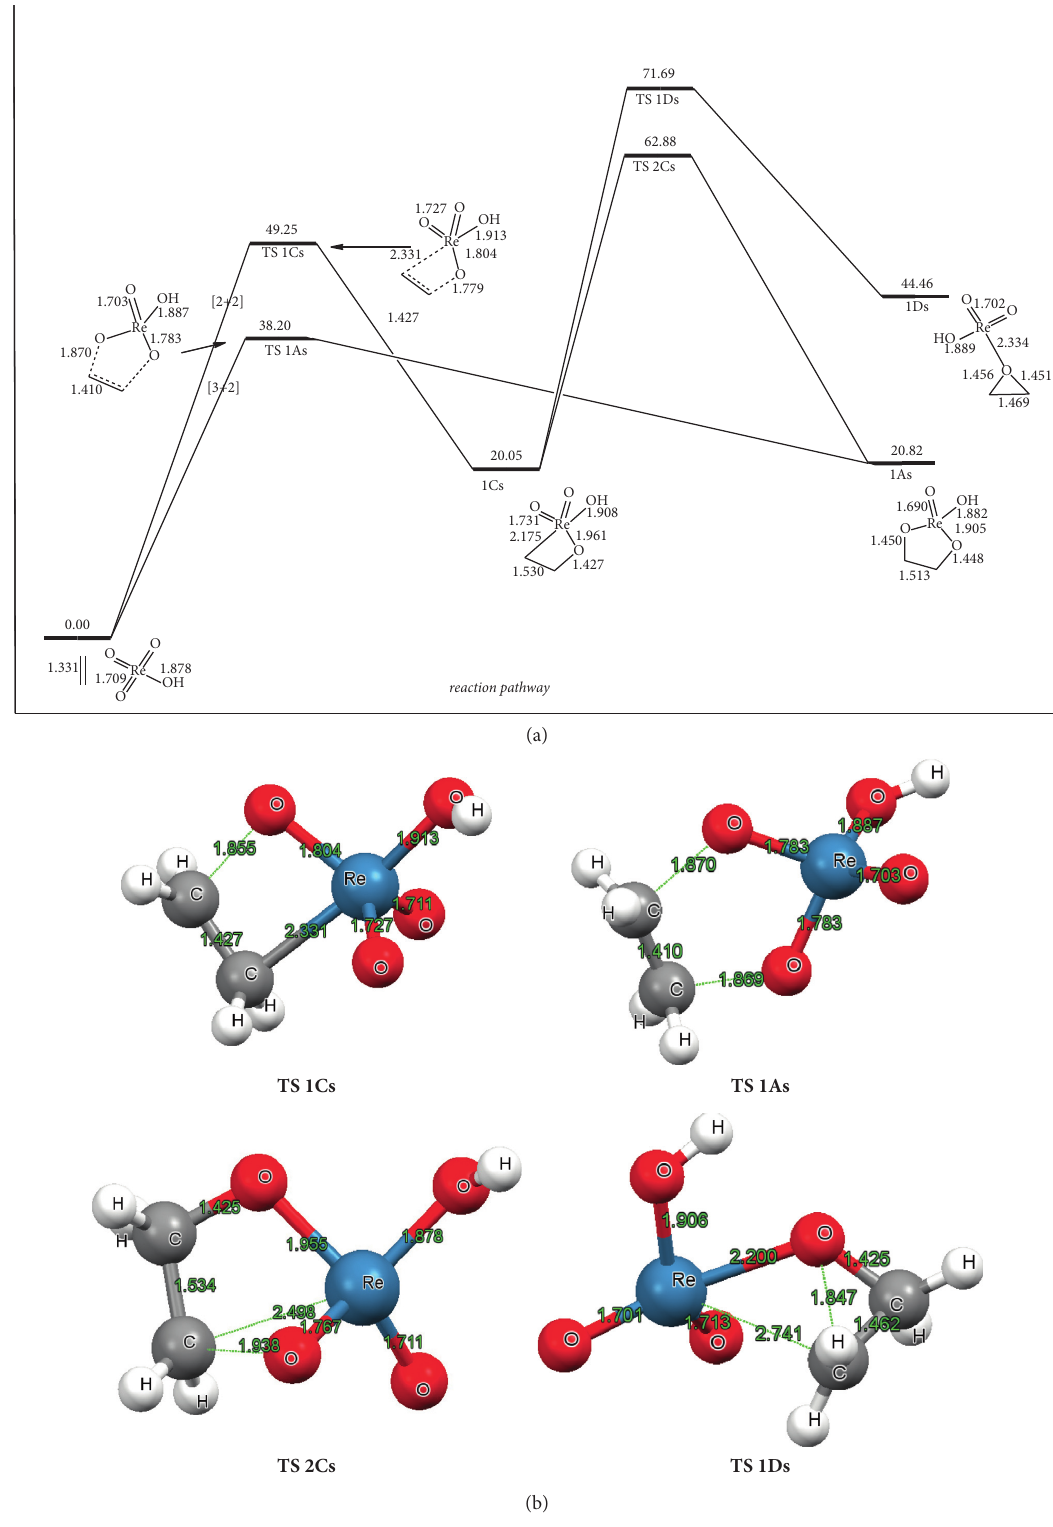
Figure 4: (a) Gibbs free-energy profile diagram for the reaction between ReO Optimized transition states involved in the reaction between ReO 3 OH and ethylene at the B3LYP/LACVP ∗ level of